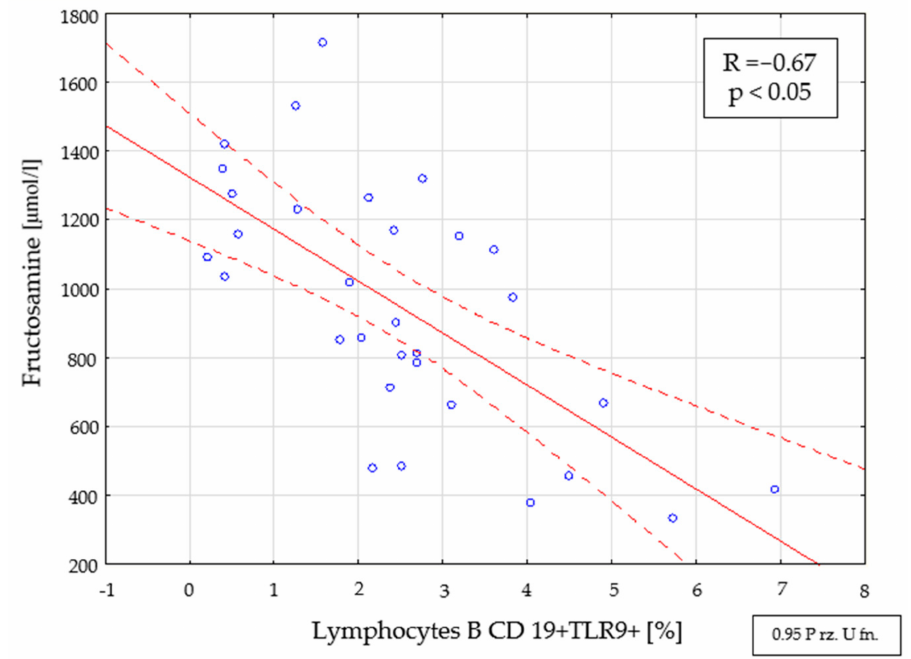
Figure 4. Relationship between the percentage of CD19+ TLR9+ B cells and the level of fructosamine in the group with newly diagnosed type 1 diabetes (<3 months from diagnosis).